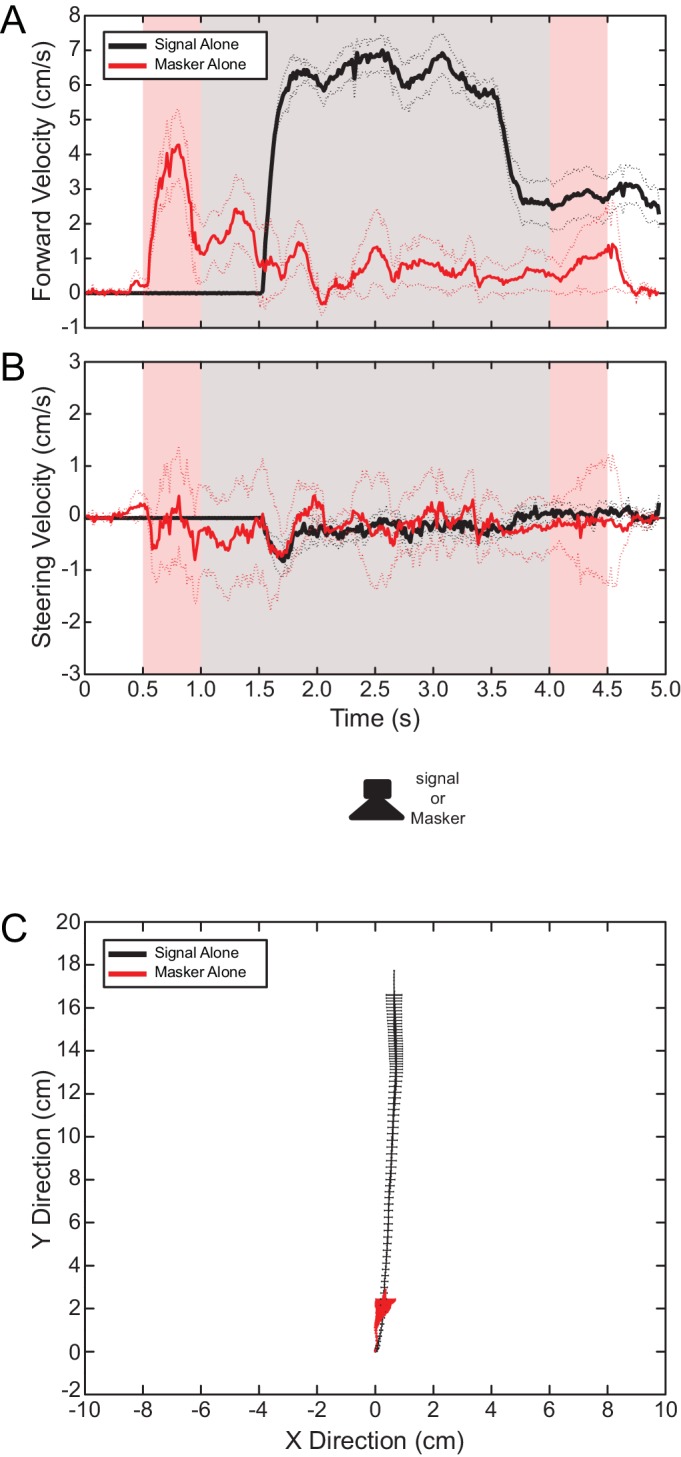
Walking phonotaxis in response to the target signal and masker in isolation.Mean (solid lines) and SEM (dotted lines) of (A) forward and (B) steering velocity components from walking phonotaxis in response to a forward (0°azimuth) target signal (black) or masker (red) presented in isolation. Light pink shaded areas indicate the duration of masker presentation. Gray-shaded areas indicate the duration of signal presentation. (C) Virtual walking trajectory showing responses directed to the target signal (black) or masker (red). Walking responses were robust and accurately directed to the target signal. In contrast, flies only walked transiently in response to the masker presented alone.DOI:
http://dx.doi.org/10.7554/eLife.20731.00310.7554/eLife.20731.004Figure 2—source data 1.Translational velocity in response to the target signal and masker presented in isolation.Masker presentation started and ended 0.5 and 4.5 s after the onset of data acquisition, respectively. Signal presentation started and ended 1.0 and 4.0 s after the onset of data acquisition, respectively. Data plotted in Figure 2A.DOI:
http://dx.doi.org/10.7554/eLife.20731.00410.7554/eLife.20731.005Figure 2—source data 2.Steering velocity in response to the target signal and masker presented in isolation.Masker presentation started and ended 0.5 and 4.5 s after the onset of data acquisition, respectively. Signal presentation started and ended 1.0 and 4.0 s after the onset of data acquisition, respectively. Data plotted in Figure 2B.DOI:
http://dx.doi.org/10.7554/eLife.20731.00510.7554/eLife.20731.006Figure 2—source data 3.Virtual walking path in response to the target signal and masker presented in isolation.‘X’ and ‘Y’ coordinates of virtual walking paths measured from the treadmill system. Data plotted in Figure 2C.